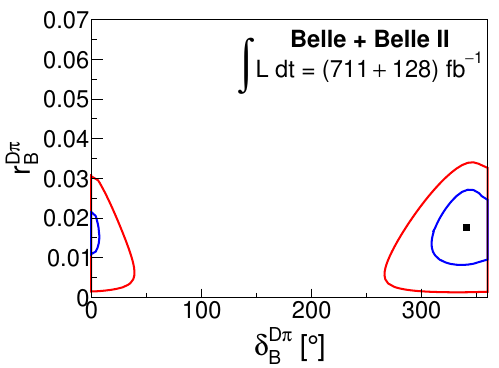
Figure 12 . Two-dimensional confidence regions at the (inner curve) 68% and (outer curve) 95%, obtained for δ Dπ ref. − r Dπ B B